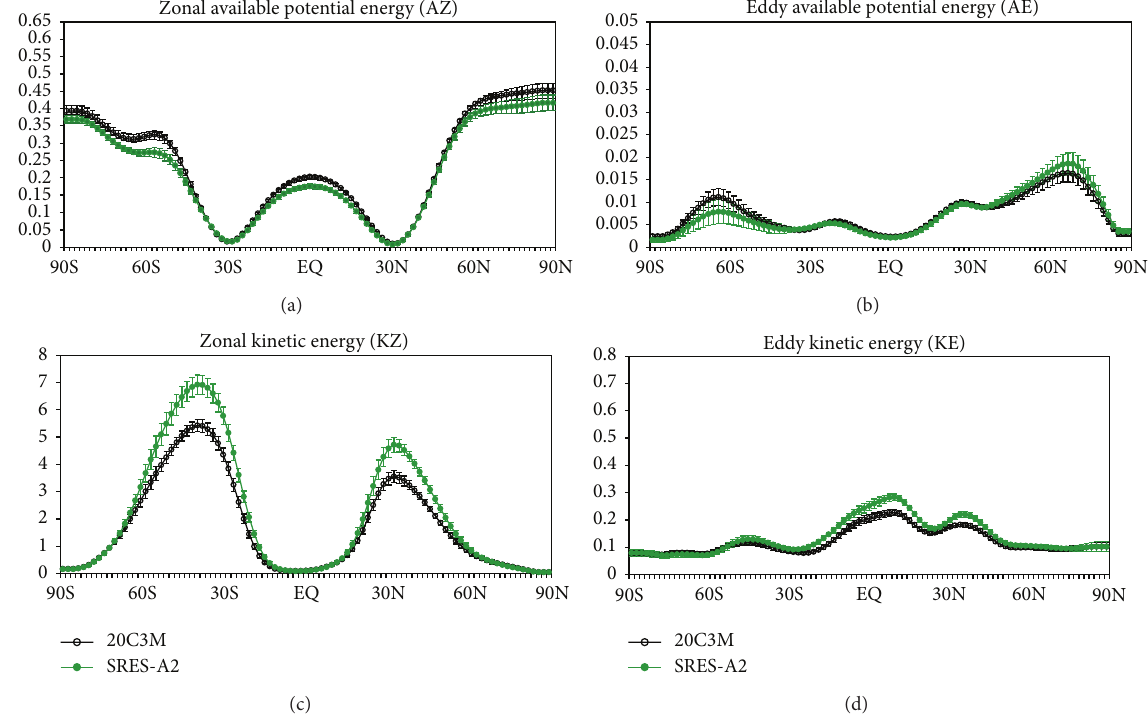
Figure 10: Annual latitudinal distribution of AZ (a), AE (b), KZ (c), and KE (d) for the 20C3M and SRES-A2 periods from an ensemble of models. Error bars indicate 95% confidence intervals about the mean. Units are 10 5 Jm −2 .